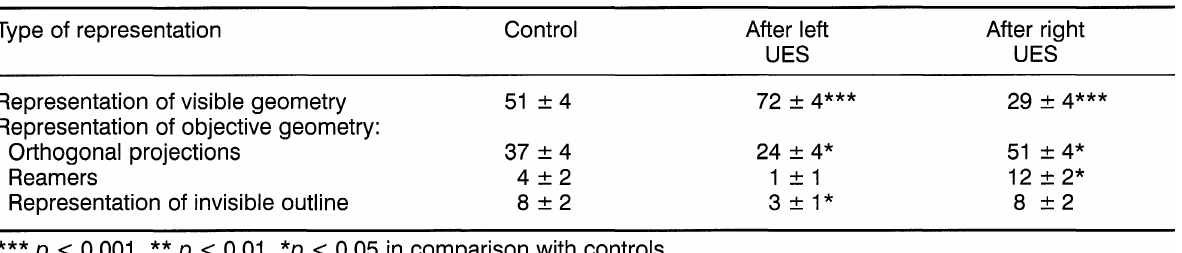
TABLE I. Frequency (%) of representations of visible and objective geometry of space after UES Type of representation Control After left After right Representation of visible geometry 51 ± 4 29 ± 4*** Representation of objective geometry: Orthogonal projections